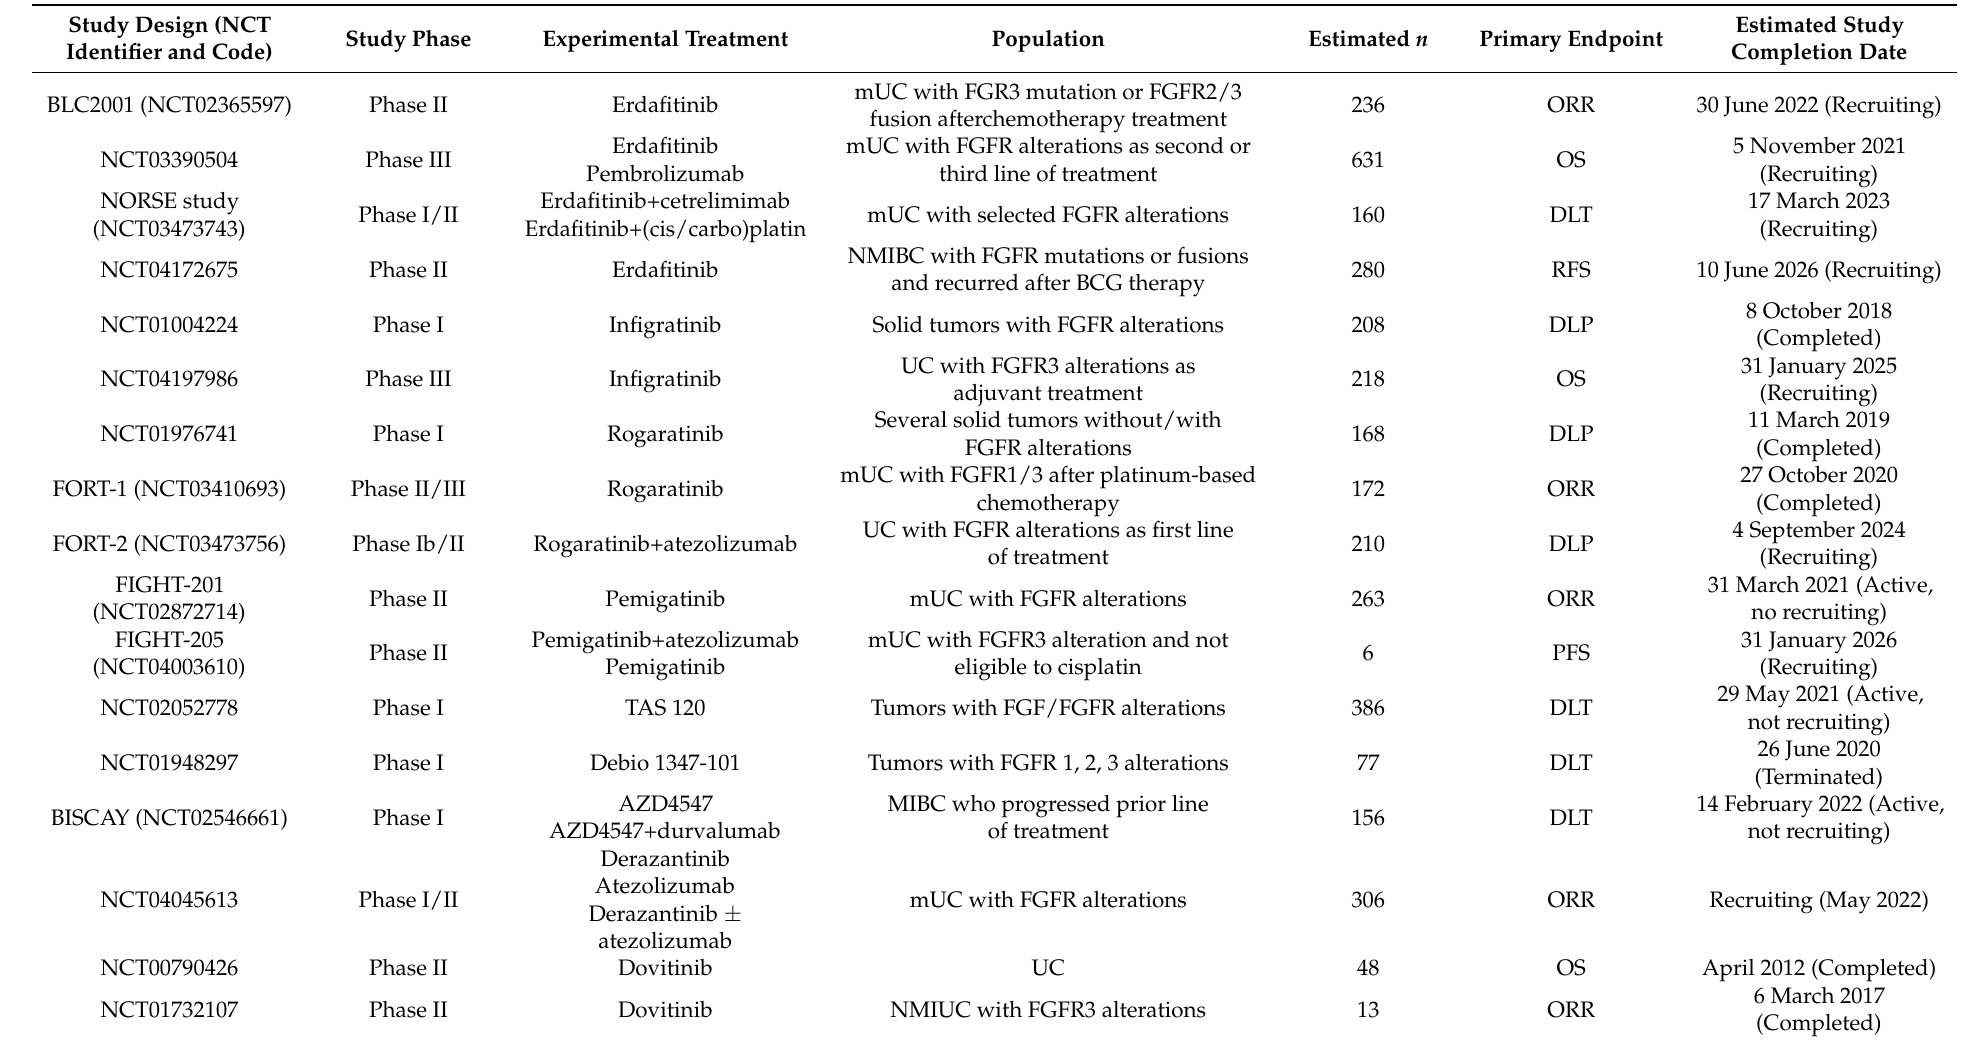
Table 2. Clinical trials of FGFR